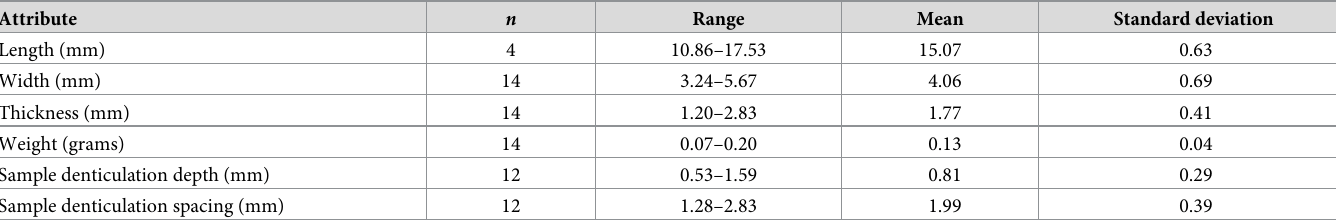
Sample denticulation spacing